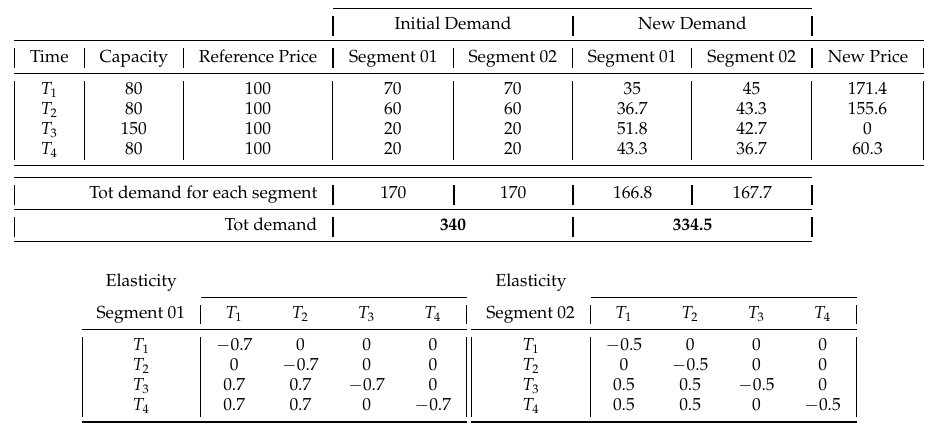
Table 9. Case Study 6.02—fourth sub-case, data, and results.